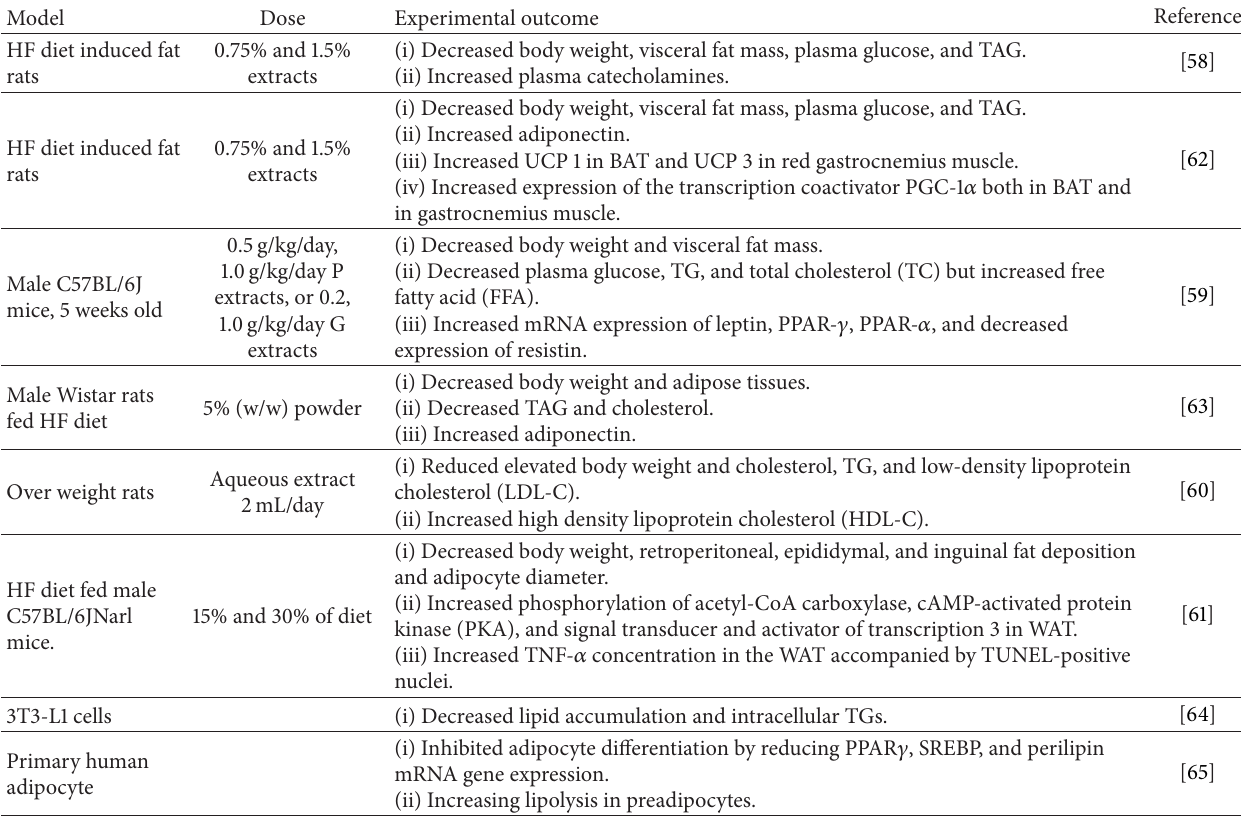
Table 1: Effect of bitter melon on body weight, obesity, and adipocyte